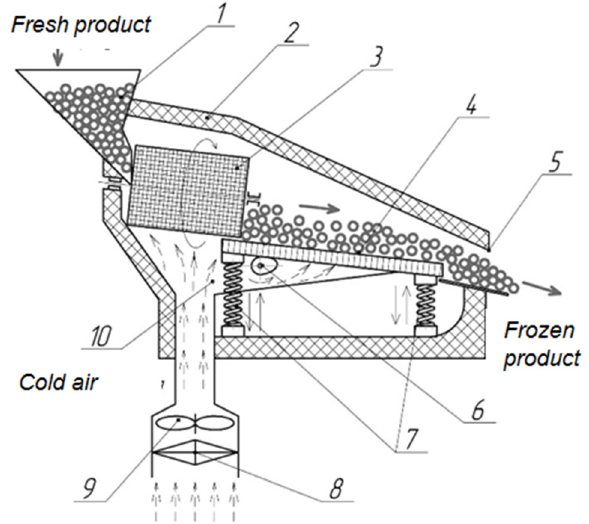
Figure 3. Functional scheme of the cascade freezer; 1—download block, 2—thermally insulated chamber, 3—a rotating hollow inclined drum made of mesh, 4—mesh conveyor, 5—unloading window, 6—eccentric mechanism, 7—springs, 8—evaporator of the refrigeration unit, 9—fan, 10—distribution channels of low temperature air.